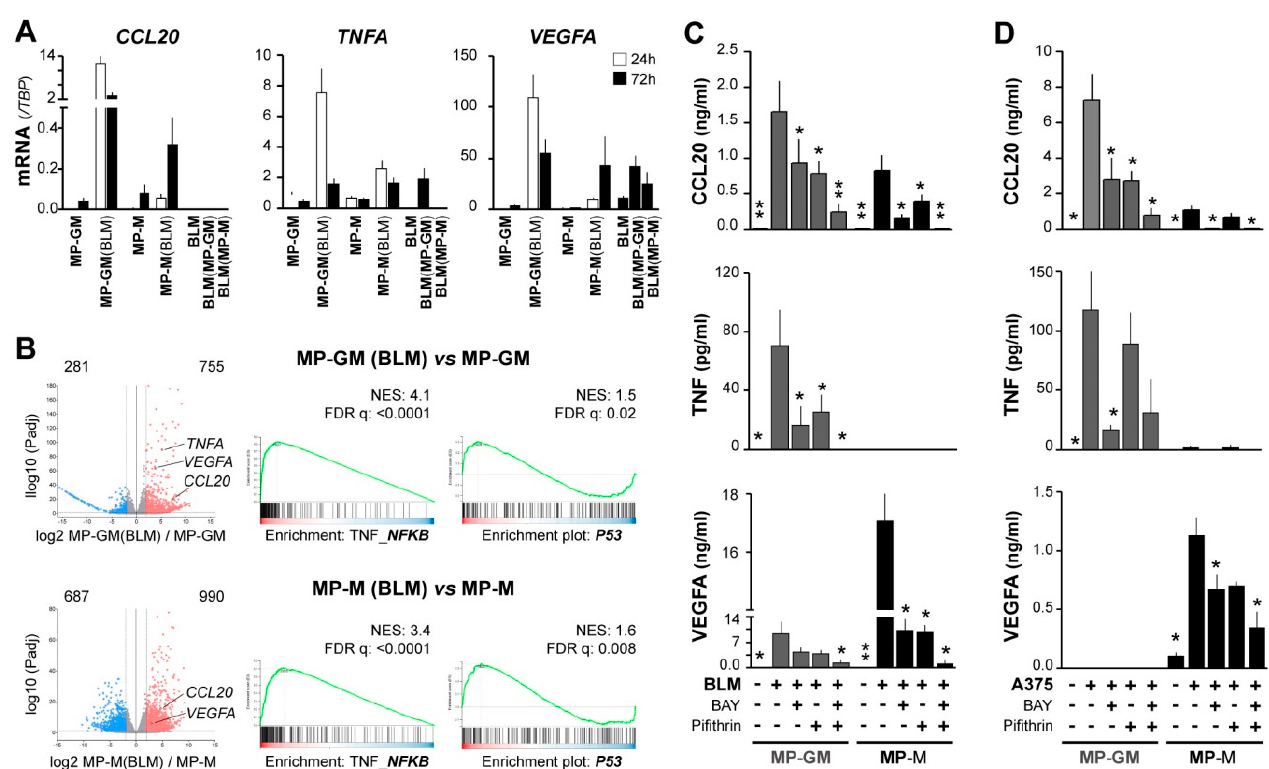
Figure 3. NF- κ B and p53 signaling pathways synergically contribute to CCL20, TNF, and VEGFA upregulation in macrophages conditioned by melanoma cells. ( A ) Macrophages differentiated with GM-CSF or M-CSF (MP-GM and MP-M, respectively) were cocultured with BLM cells for 24 h or 72 h, as specified, and then separated with anti-CD14-coated beads. Mutually conditioned cells were measured for CCL20 , TNF , and VEGFA mRNA expression relative to TBP ( n = 3– 5 donors). ( B ) Volcano plots showing DEG scores for 24h BLM-conditioned macrophages vs. unconditioned macrophages, as well as GSEA analyses showing normalized enrichment scores and false discovery rates ( n = 3). ( C , D ) Conditioned media assessed for CCL20, TNF, and VEGFA protein secretion. As in A, differentiated macrophages were cocultured with BLM ( C ) or A375 ( D ) melanoma cells for 72 h in the absence or presence of 10 μ M BAY11-7082 (NF- κ B inhibitor) and/or 50 μ M Pifithrin- α (p53 inhibitor), as indicated ( n = 5–10). Asterisks denote statistically significant differences relative to melanoma/macrophage condition cocultured without inhibitors (paired t-test; * p < 0.05; ** p < 0.01).